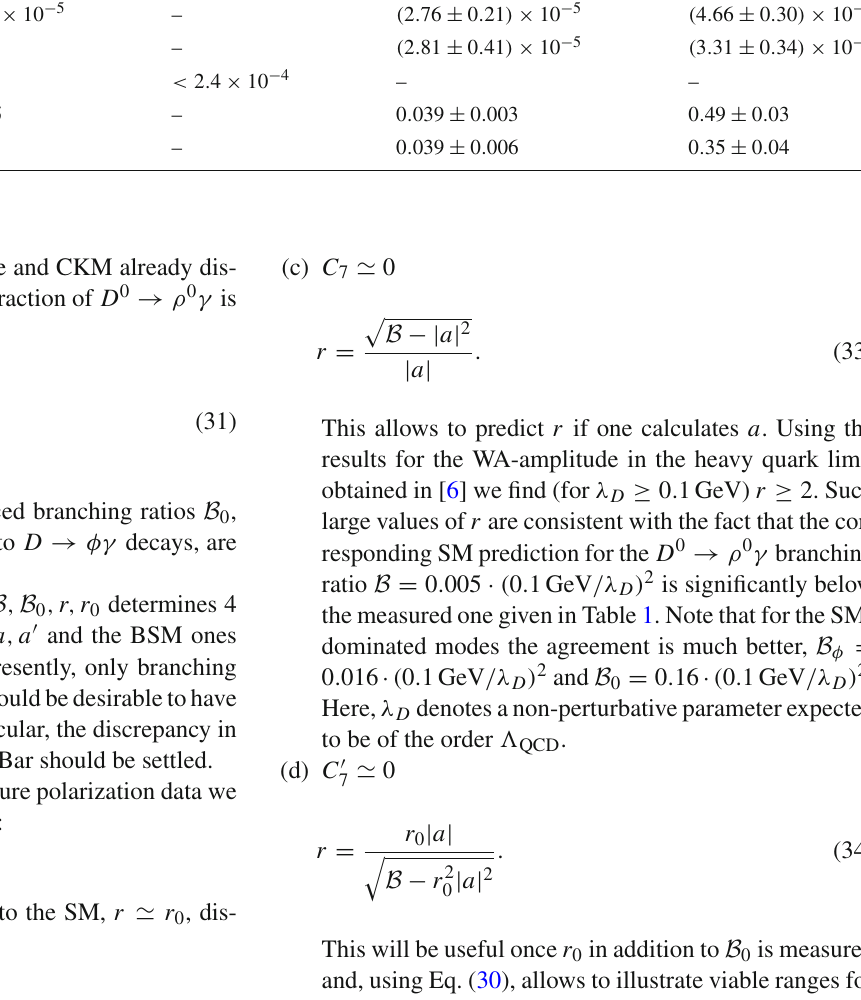
Table 1 Experimental data on D 0 → V γ branching ratios. The corresponding numerical values for the reduced branching ratios B , see Eqs. (26, 29) and analogously for φγ , are given in the last row. † Statistical and systematic uncertainties are added in quadrature Branching